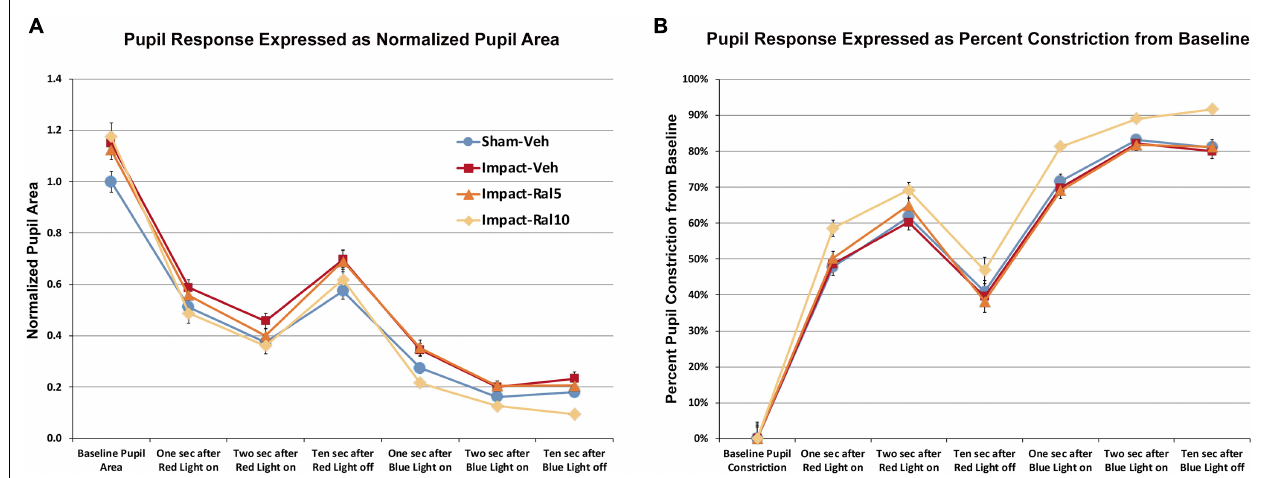
FIGURE 4 | Pupil responses to red and blue light ∼ 7 months after impact. (A) Pupil area is shown normalized to the pre-illumination baseline for sham mice. Pupil size at rest was greater in all groups of impact mice (including drug treated) than in sham mice ( p = 0.0362), as well as during red light in the case of impact-vehicle mice ( p = 0.0059) and blue light in the case of impact-vehicle mice ( p = 0.0009) and impact-ral5 mice ( p = 0.0033). (B) Pupil size is plotted as the % constriction from baseline for each group of mice. The % constriction during red and blue light was no different in sham, impact-vehicle, and impact-ral5 mice. Although 10 mg/kg raloxifene did not rescue the increase in resting pupil size caused by impact ( p = 0.0086), it did normalize the absolute magnitude of constriction caused by red light and yielded hyperconstriction to blue light ( p = 0.0014). As a result, % pupil constriction from baseline in response to blue light was significantly greater in impact-ral10 mice than in sham ( p = 7.6 × 10 − 8 ), as was the % constriction to red light ( p = 0.0001). Errors bars are SEMs. Animal numbers: 21 sham-vehicle mice, 25 impact-vehicle mice, 22 impact-ral5 mice, and 14 impact-ral10 mice.